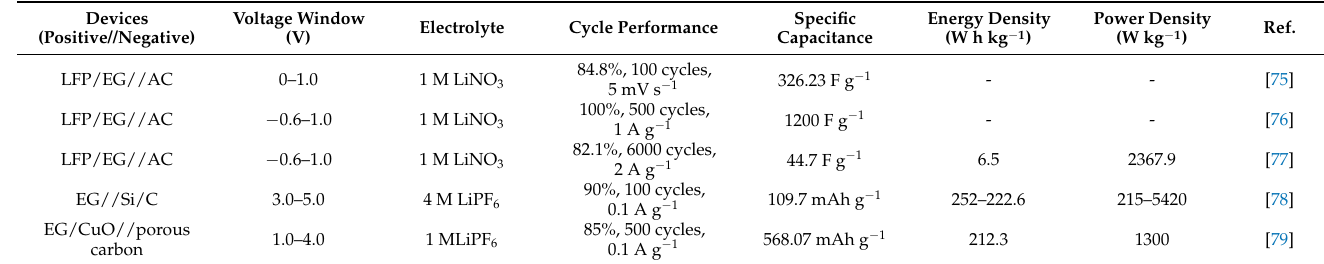
Table 3. Summary of hybrid supercapacitor using EG-based materials as electrode